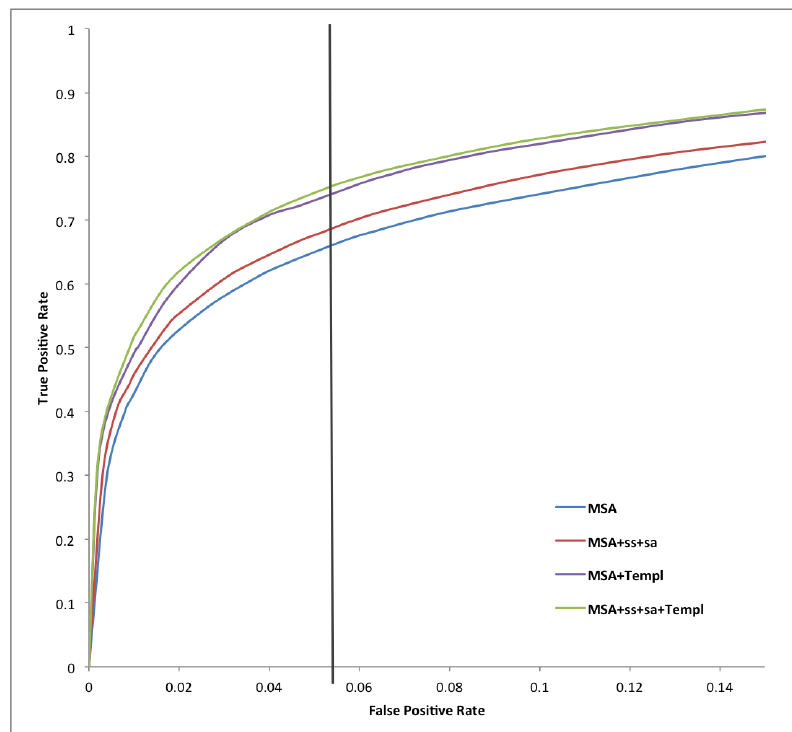
Figure 3. Receiver-operating characteristic curve for X-ray test set data showing the FPR in the region from 0% to 14% false positives for all of our methods. The vertical line represents the decision thresholds corresponding to a predicted 5%